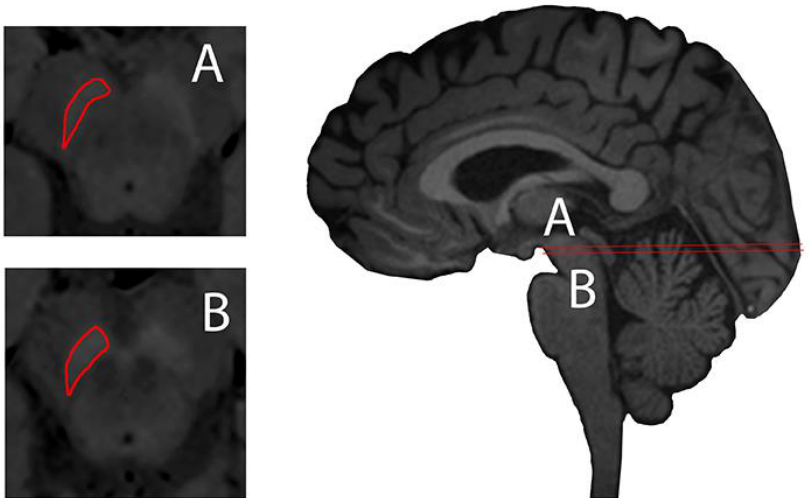
Figure 2. Substantia nigra delineated (red) axial plane of neuromelanin-sensitive Magnetic Resonance (MR) imaging (left, A and B) and sagittal midline plane of a 3D T1-weighted MPRAGE illustrating axial planes of ROI delineation. Images taken on a 3 Tesla Siemens Magnetom Trio system with a 32-channel phased-array head coil. Reprinted with the permission of [16].